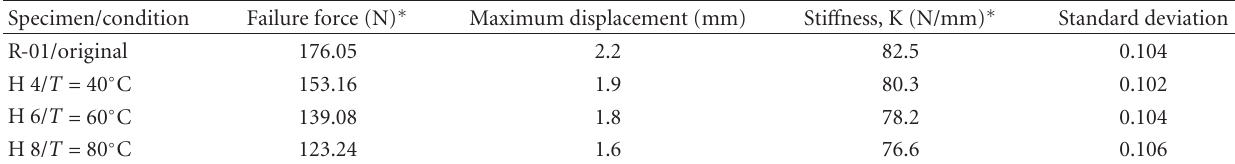
Table 2: Bending test results for specimens aged at various temperatures (humidity 60%).